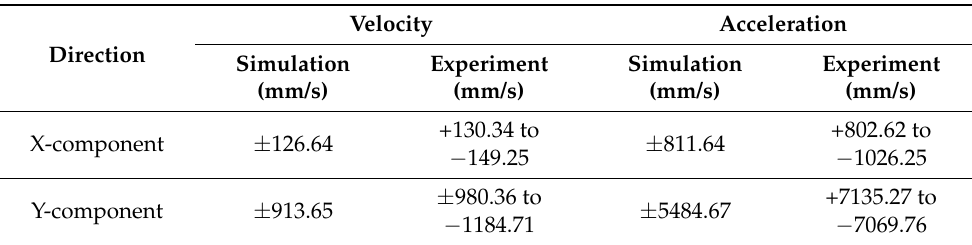
Table 7. Comparison of simulated and experimental velocity and acceleration for X and Y compo-